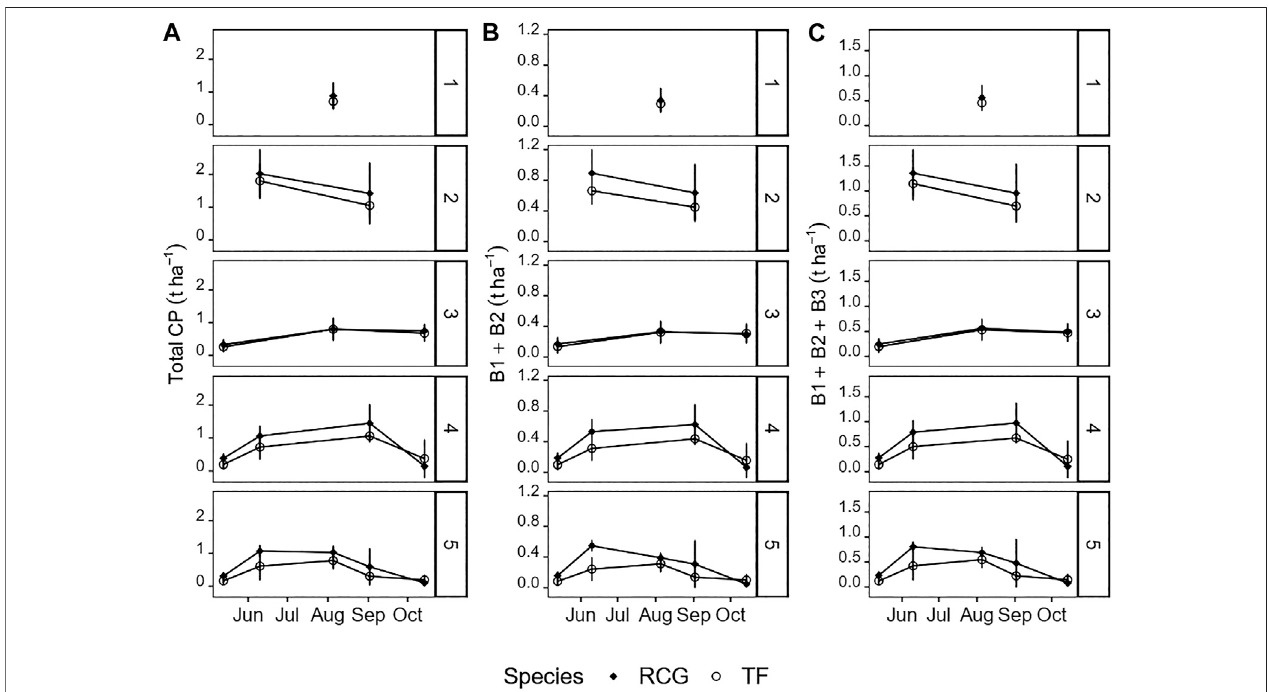
FIGURE 4 | Yields (t DM ha − 1 ) of (A) total crude protein (CP), (B) protein fractions B 1 + B 2 , and (C) protein fractions B 1 + B 2 + B 3 for the various treatments and species on the different harvest dates. Attention should be paid to the different magnitudes of the y-axes. Error-bars show standard deviations.